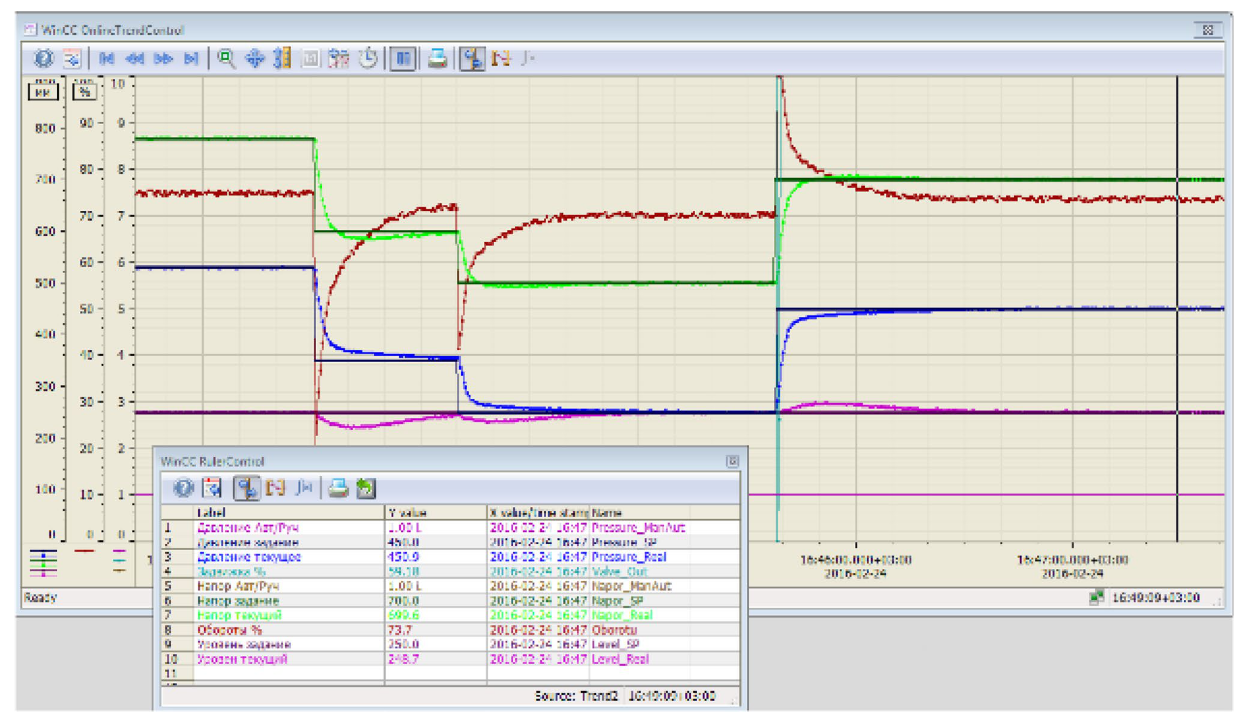
Fig. 12 Trends in operation of automated control system for the technological process of production with noise-proof extreme control of paper production with